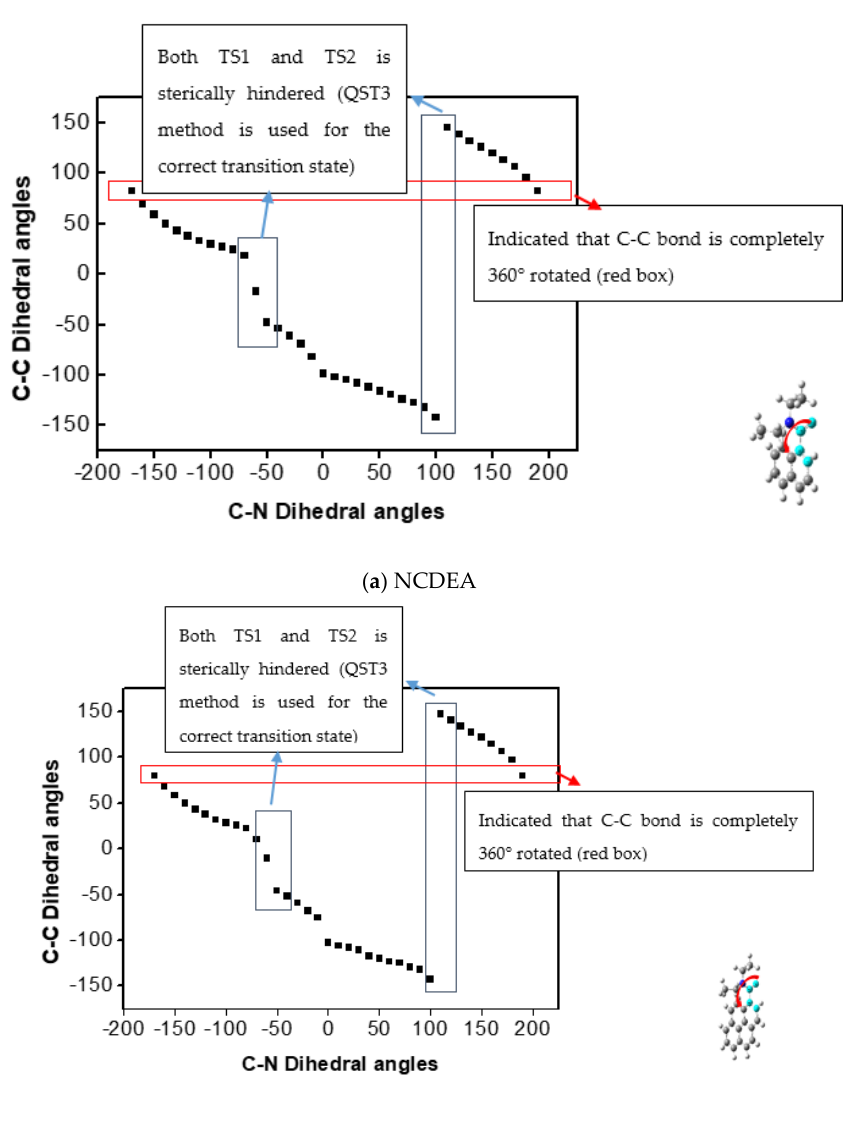
Figure 4. Dihedral angle of Aryl-CO bond (Highlighted) (Y axis) versus dihedral angle of C-N bond (Arrowed) (X axis) in ( a ) NCDEA and ( b ) PCDEA.